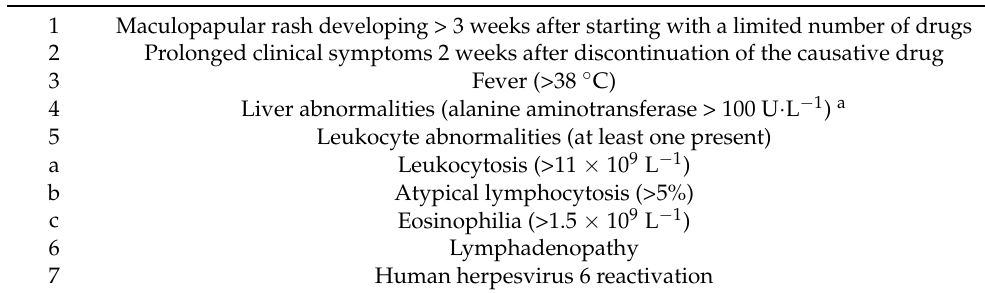
Table 1. Diagnostic criteria for drug-induced hypersensitivity syndrome (DIHS) established by a Japanese consensus group [1].